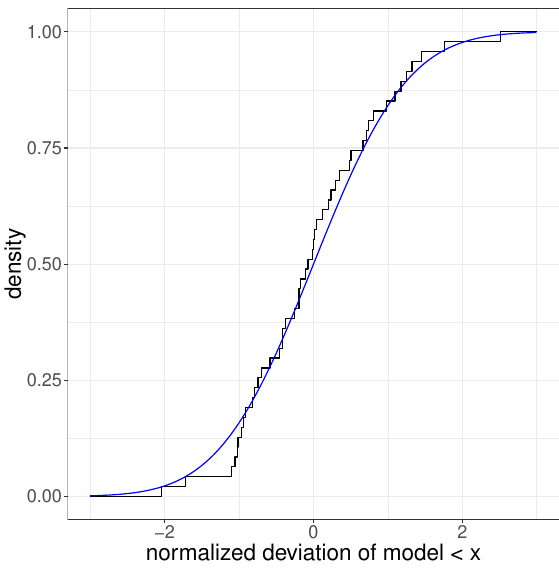
Figure 13 . We plot the cumulative distribution function of the relative differences of model and measurements observed in figure 12 in black along with the cumulative distribution function of the standard normal in blue. A maximal deviation between the cumulative distribution functions of d max = 0 . 092 is observed. A Kolmogorov-Smirnov test (at 95% with a critical value of 0.215 at 40 degrees of freedom) is successfully passed, giving faith in the suitability of the fitting ansatz as well as the estimation of error bars in the statistical analysis of the Monte Carlo